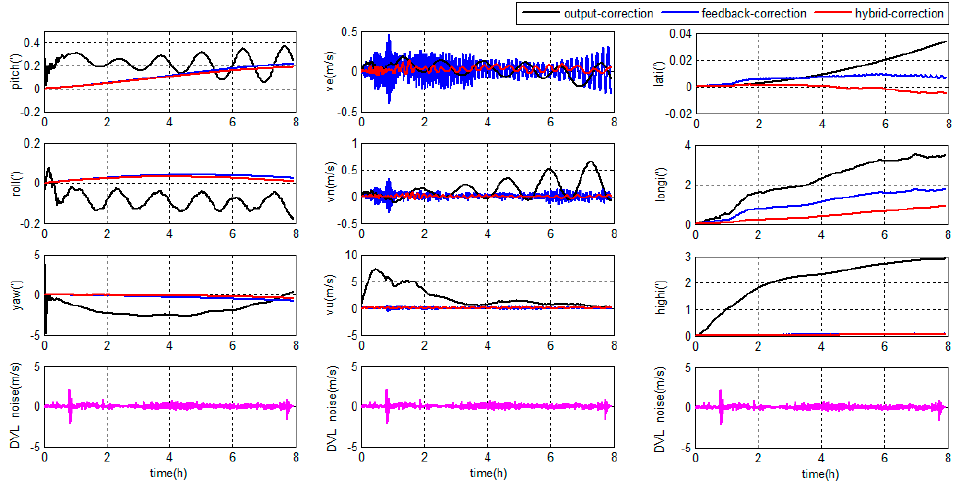
Figure 19. Integrated navigation errors in the high latitude regions.